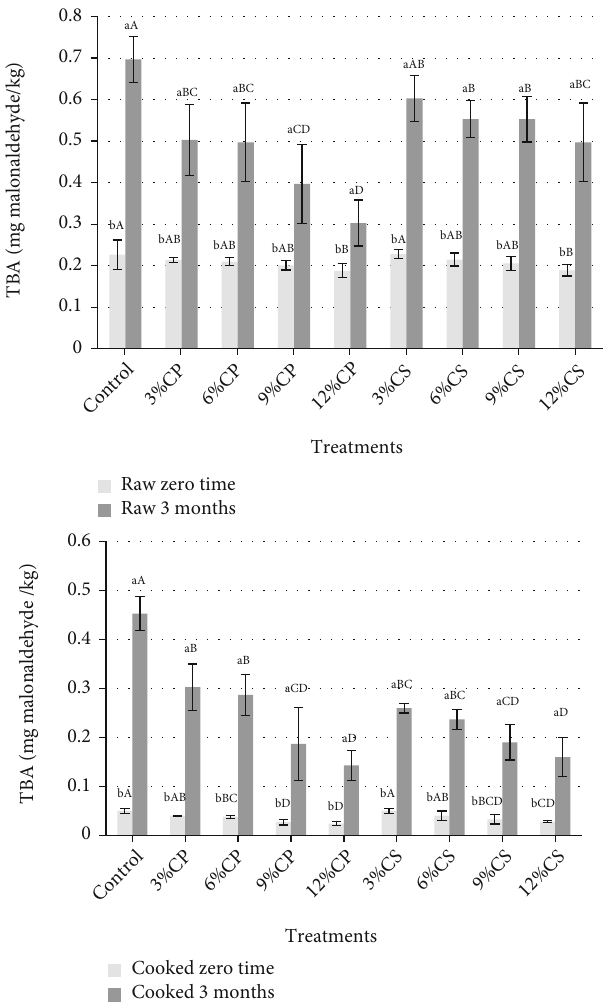
Figure 3: Changes in thiobarbituric acid (TBA) assay of raw and cooked chicken patties supplemented with cantaloupe peel (CP) and seeds (CS) powder during storage at -20 for 3